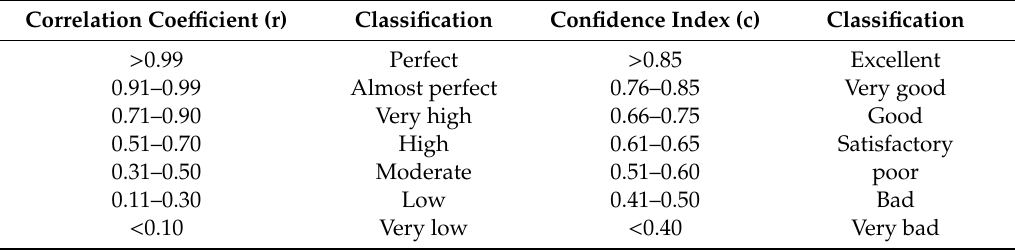
Table 1. Performance classification for Pearson’s correlation coe ffi cient (r) and confidence index (c) [33,35].